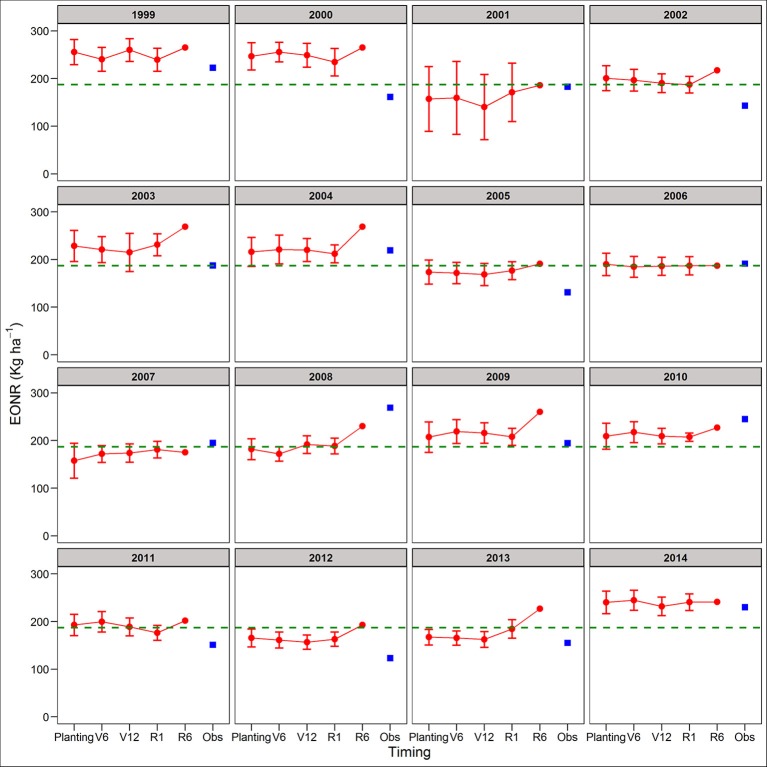
Predicted and observed economic optimum N rate (EONR) for corn-corn. The connected red dots indicate APSIM model predictions at planting time, V6 (6th leaf), V12 (12th leaf), and R1 (silking) stages using actual and historical weather data (vertical bars indicate standard deviation, n = 35). At maturity (R6), the weather is known so there is no uncertainty in yield prediction. Blue squares represent the observed EONR. The green dashed line represents the mean EONR for the study period at this site.